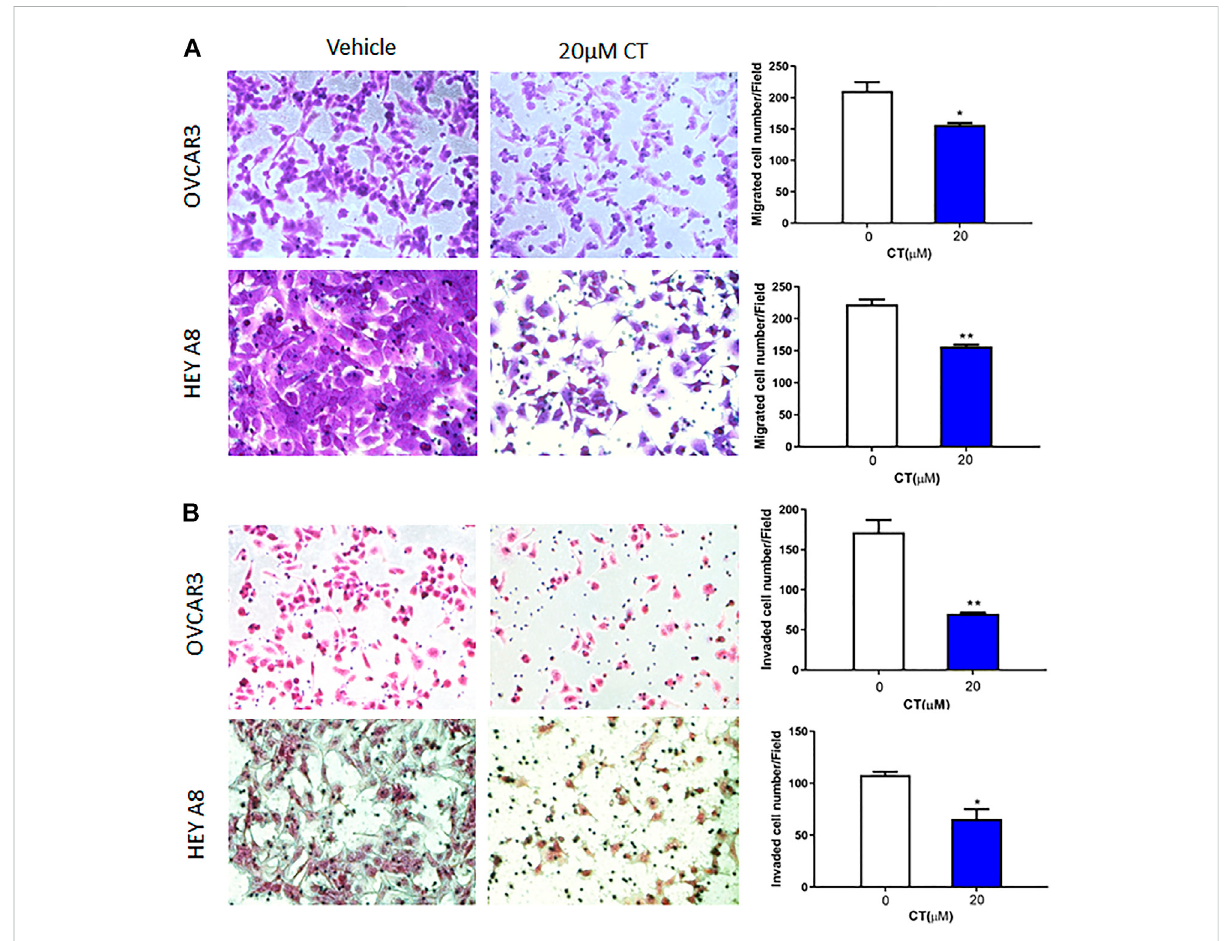
CTinhibitsovariancellmigrationandinvasion. (A) TranswellmigrationassaywasperformedinOVCAR3andHEYA8cellstreatedwith20 μ MCT for24 h.Migratedcellswerestainedusingcrystalvioletandcounted. (B)